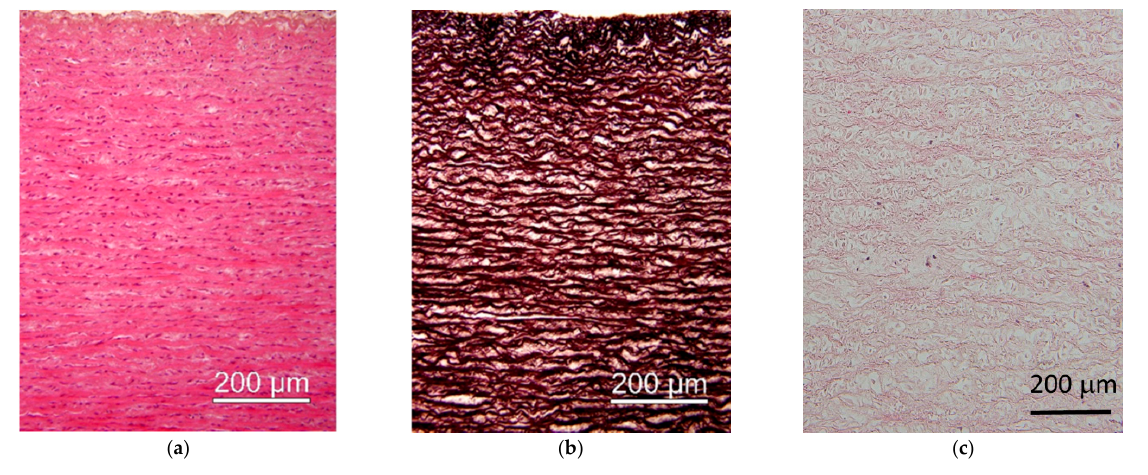
Figure 10. Micrographs of tissue of animal origin (aorta): ( a ) routine (HE) staining showing normal architecture of the media (positive control); ( b ) regular elastic lamellae visualized by staining for elastic element in control sample; ( c ) image of the acellular tissue resulted from the chemical, conventional decellularization technique (HE staining) (negative control).